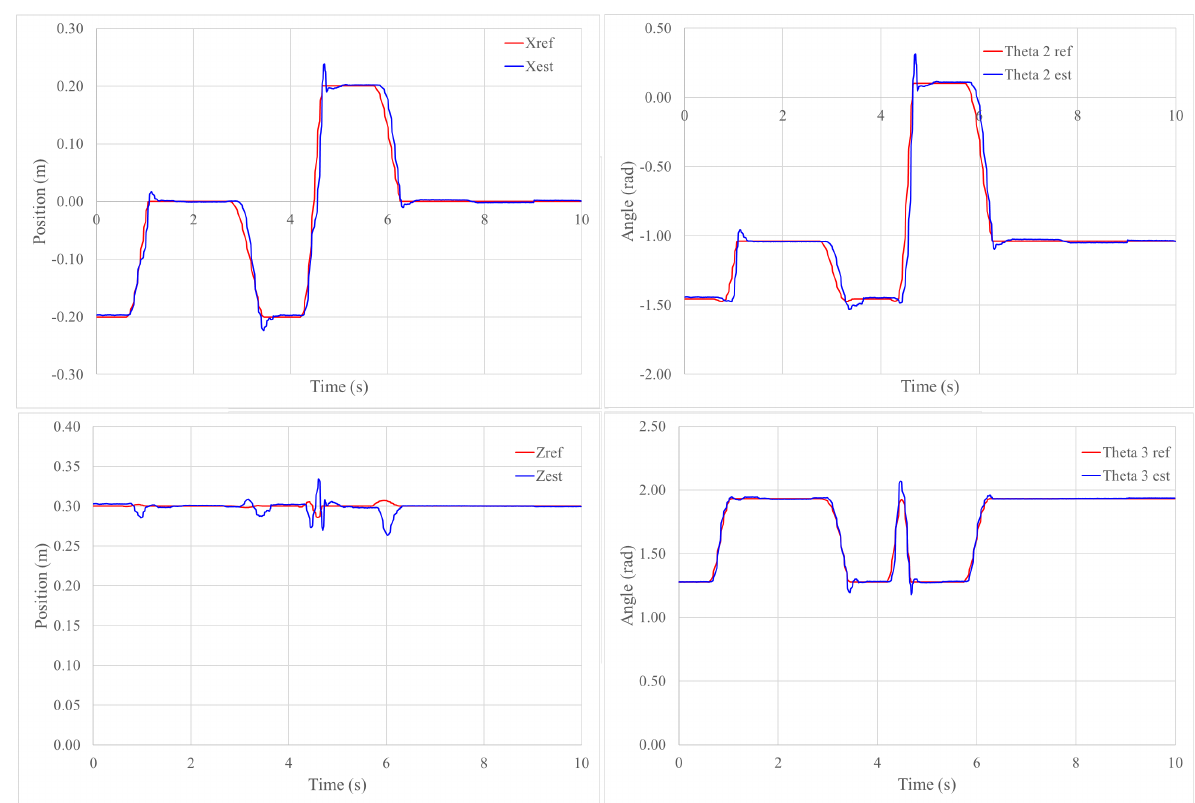
Figure 17. Trajectory Following Results—Test Set 2.